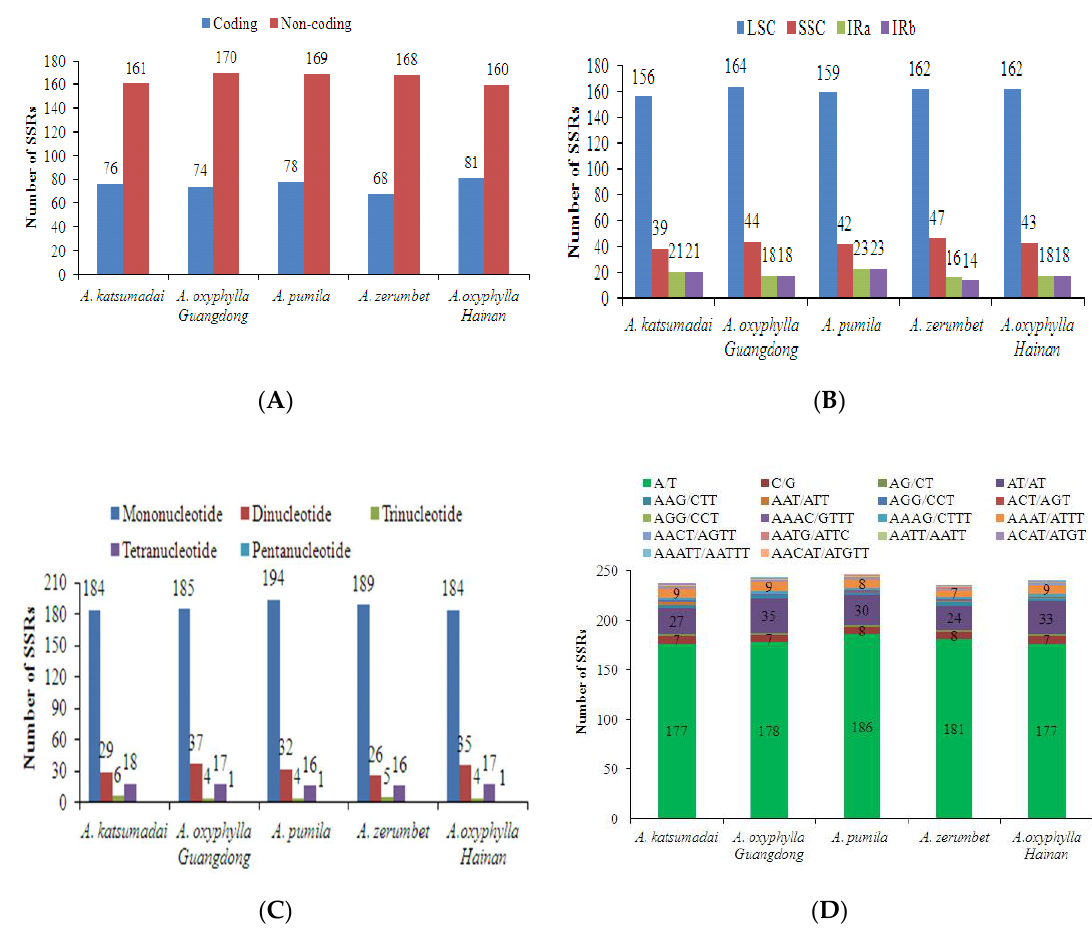
Figure 3. Distribution of small sequence repeats (SSRs) in the chloroplast genomes of five Alpinia accessions. ( A ) SSR distribution between coding and non-coding regions detected in five Alpinia chloroplast genomes; ( B ) Frequencies of identified SSRs in the large single copy (LSC), SSC and inverted repeats (IRs) regions; ( C ) Number of di ff erent SSR types detected in five Alpinia chloroplast genomes; ( D ) Frequency of identified SSRs in di ff erent repeat class